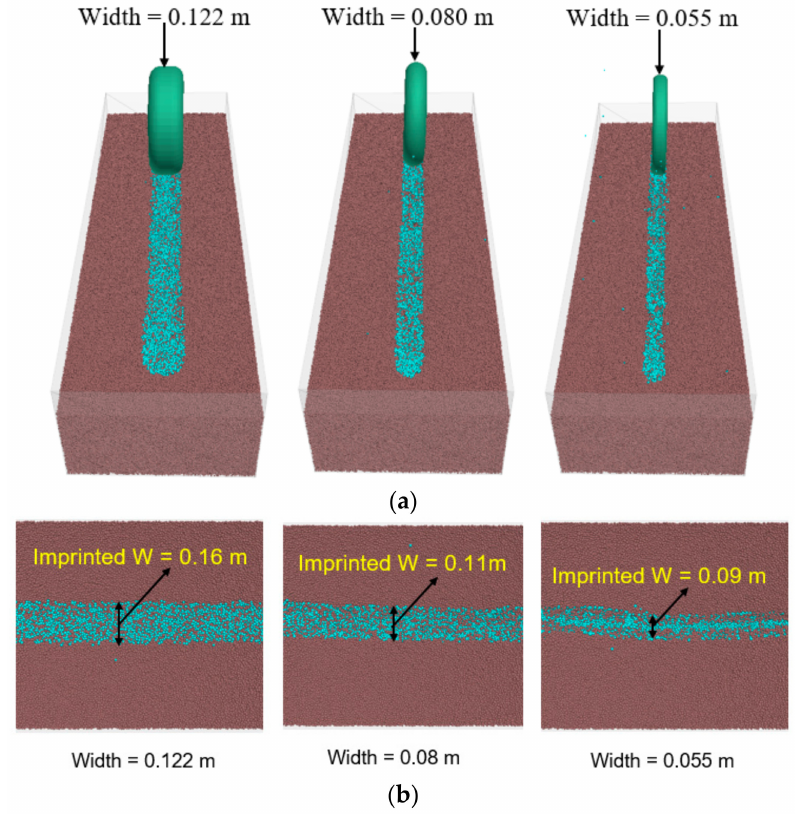
Figure 9. ( a ) Simulation of press-wheel under different widths (W); ( b ) imprinted widths for 0.122 m, 0.08 m and 0.055 m press-wheels after passage on soil with medium moisture content level.